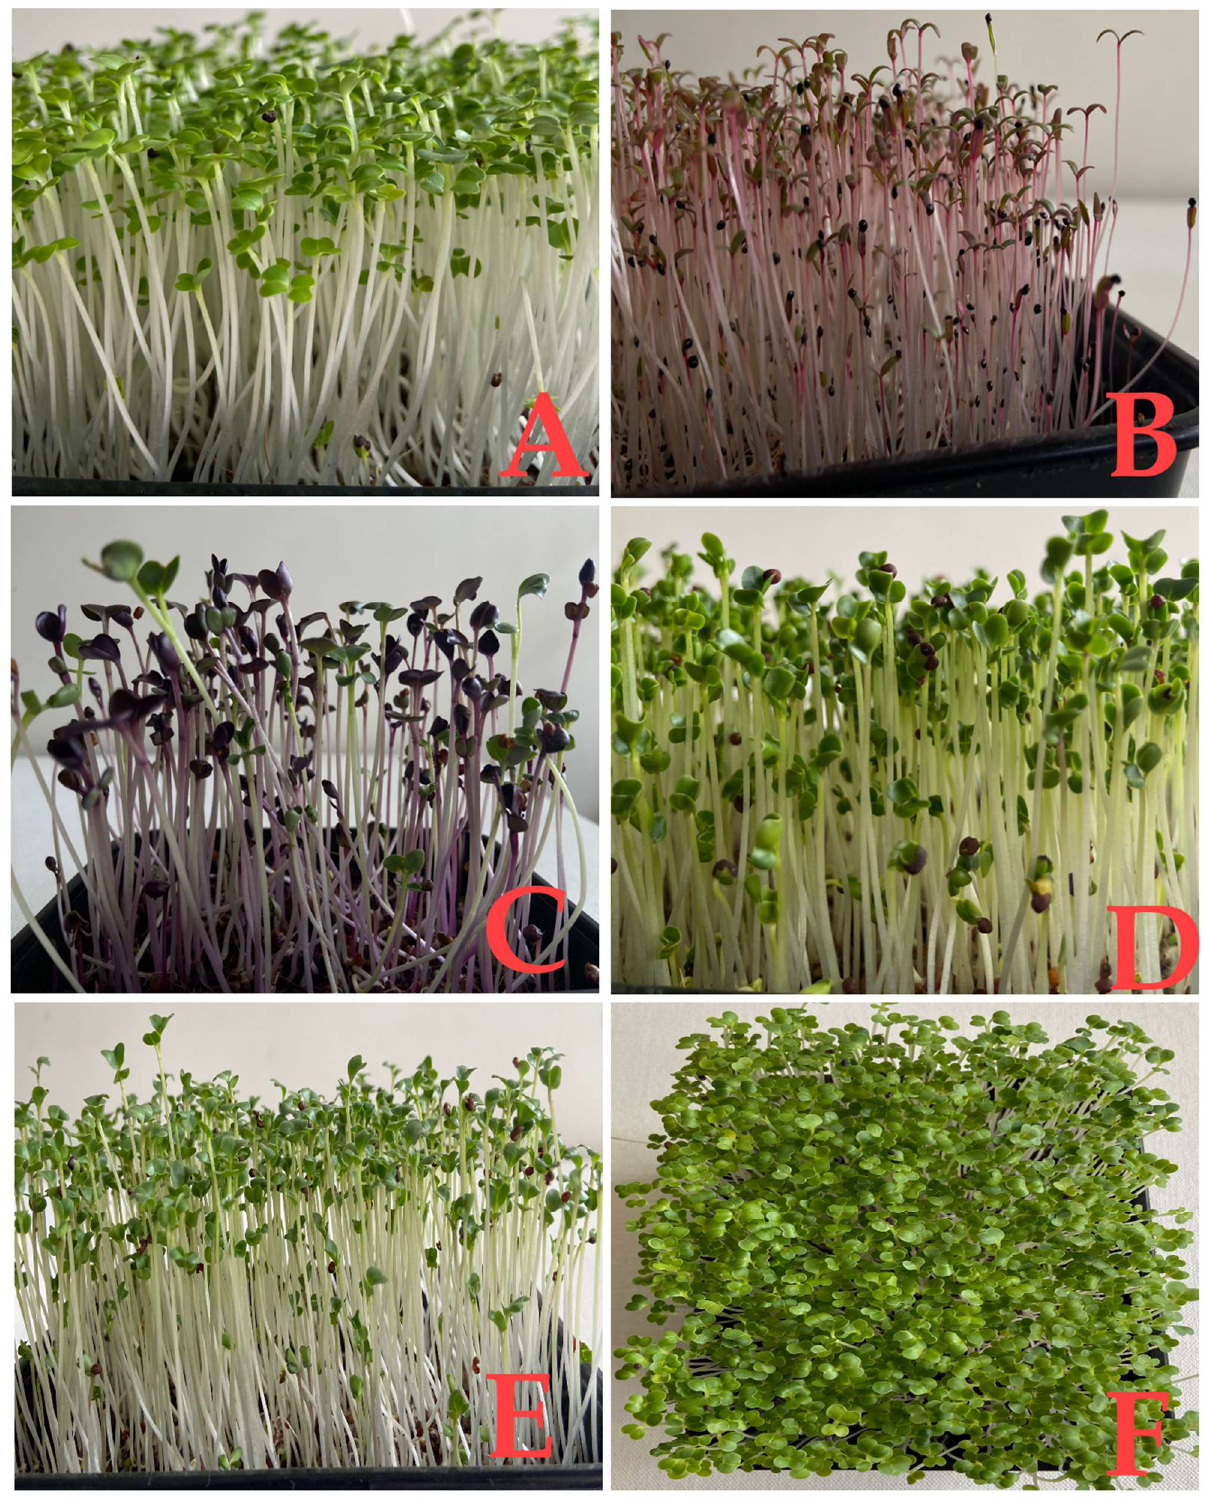
Figure 1. Different microgreens grown in a lab. ( A ) Bok choy, ( B ) Red amaranth, ( C ) Purple radish, ( D ) Kale, ( E ) Broccoli, and ( F ) Bok choy—top view.